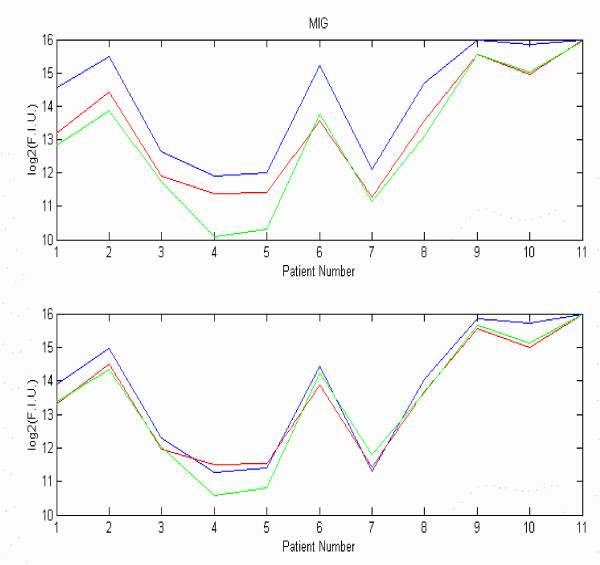
Effect of Normalization. The top panel reveals the raw data, shown as the Log2(MFI), for the analyte Monokine induced by interferon gamma (MIG) across three replicates with 11 patient samples (numbered on the X-axis). The bottom panel reflects the impact of normalization in reducing variation in intensity within each sample and hence the replicate MFI CV.